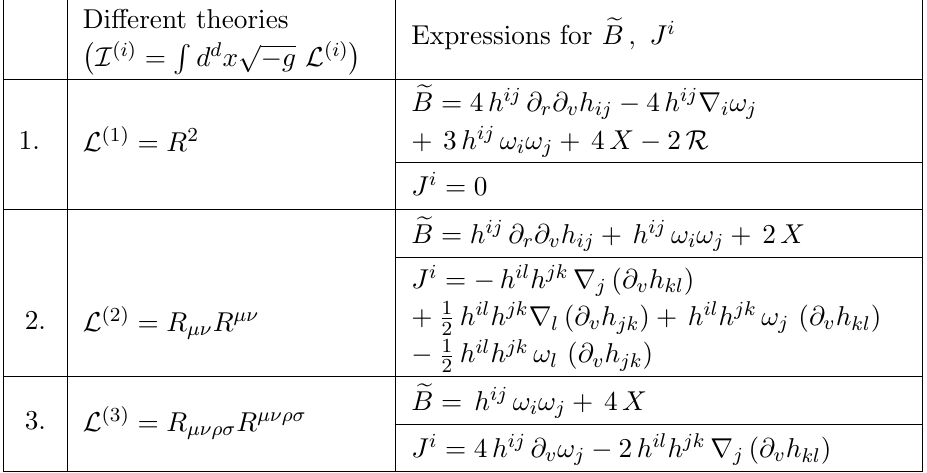
Table 12 . e B and J i ’s for di(cid:11)erent four derivative theory of gravity. While writing the expressions we have used the values for the coe(cid:14)cient A 2 in each of the three cases as following: (i) for R